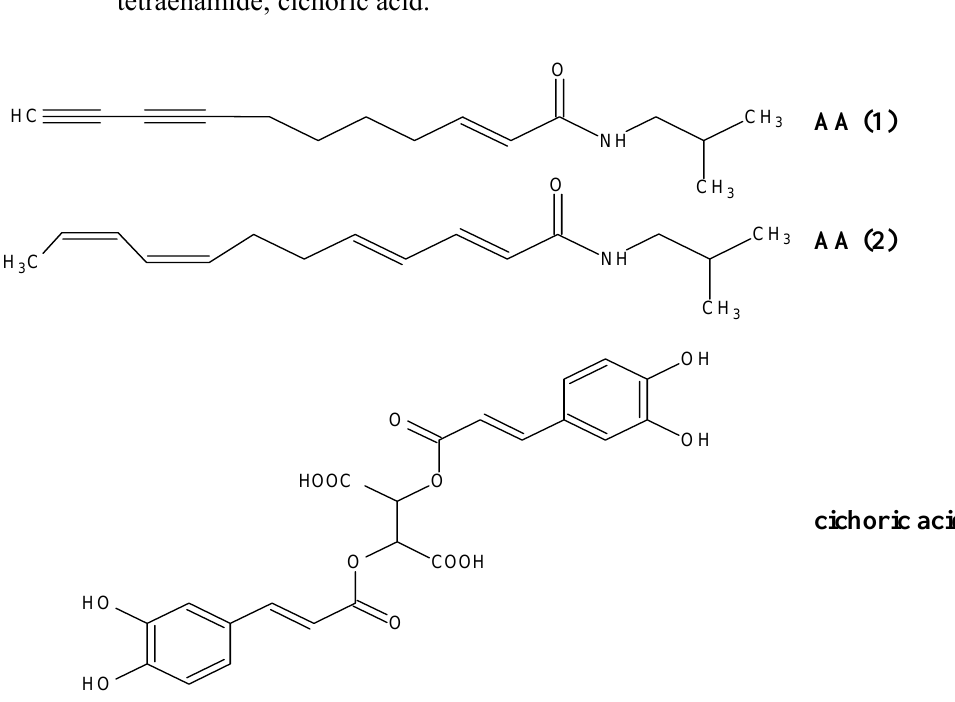
Figure 1: Structures of alkylamides and cichoric acid. ( AA 1 ) (2E)-N-isobutylundeca- 2-ene-8,10-diynamide; ( AA 2 ) (2E,4E,8Z,10Z)-N-isobutyldodeca-2,4,8,10- tetraenamide; cichoric acid.